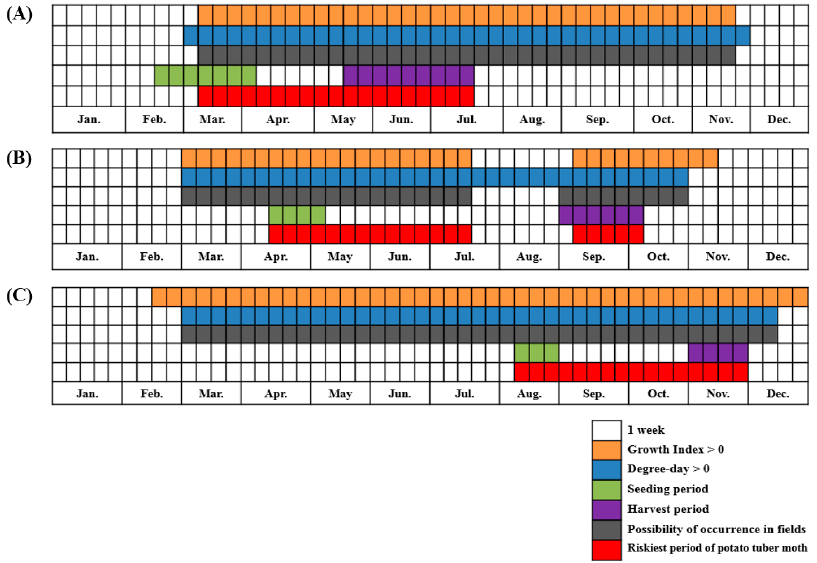
Figure 6. Timelines of seasonal occurrences of potato tuber moths in potato cultivation fields under the current climate for ( A ) spring potato (Seosan), ( B ) summer potato (Hongcheon), and ( C ) fall potato (Jeju).